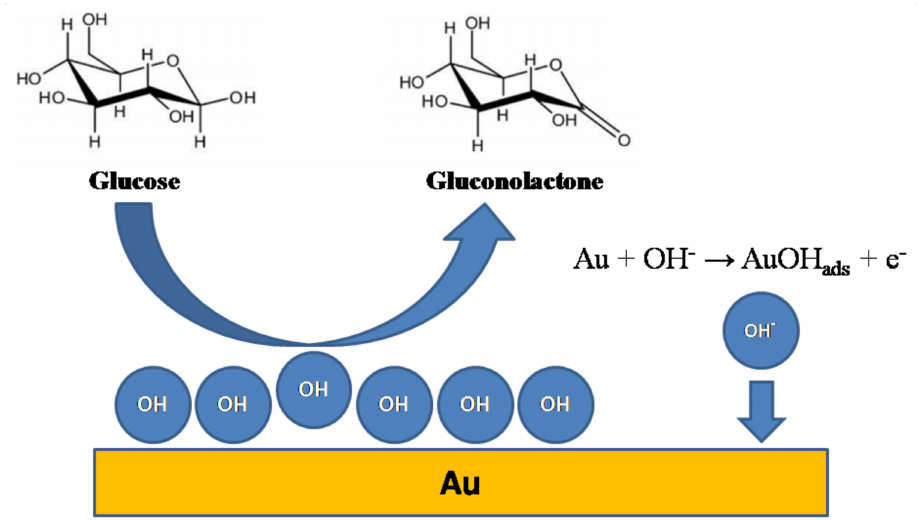
Figure 1. Schematic representation of the incipient hydrous oxide / adatom mediator (IHOAM) model of glucose oxidation on the gold